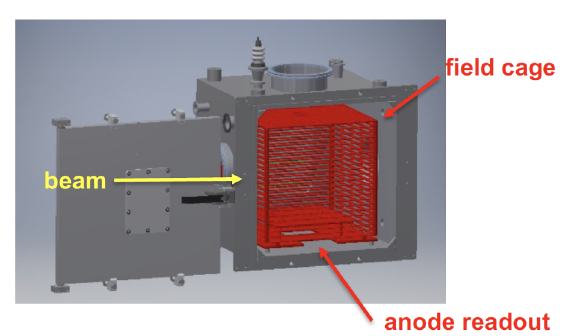
Figure 12. Schematic diagram of the ND-cube time projection